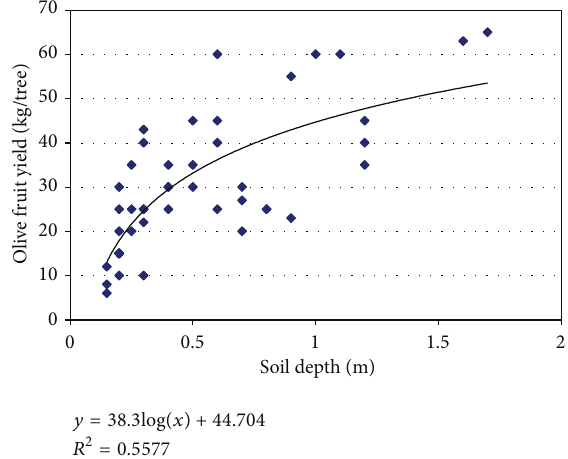
Figure 4: Regression between individual olive tree fruit yield ( 𝑁 = 47 ) and soil